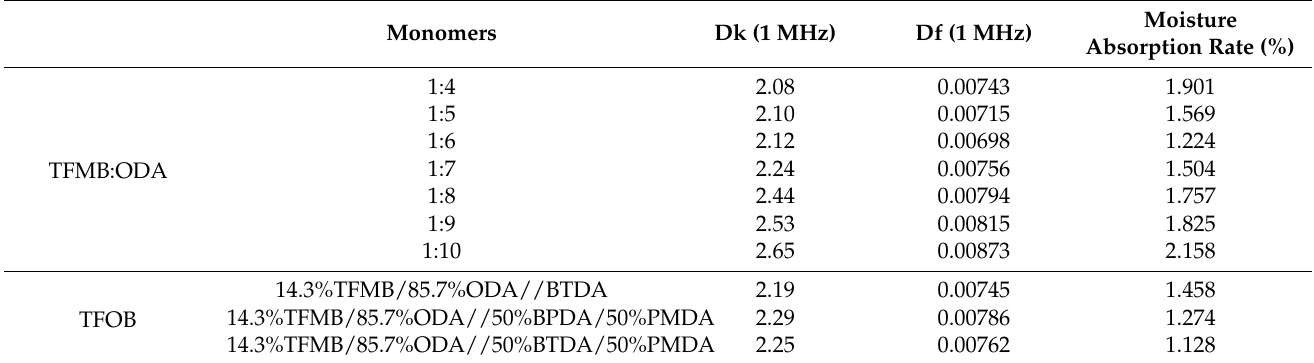
Table 7. Dielectric properties and hygroscopic of PI films in group TFOP and group